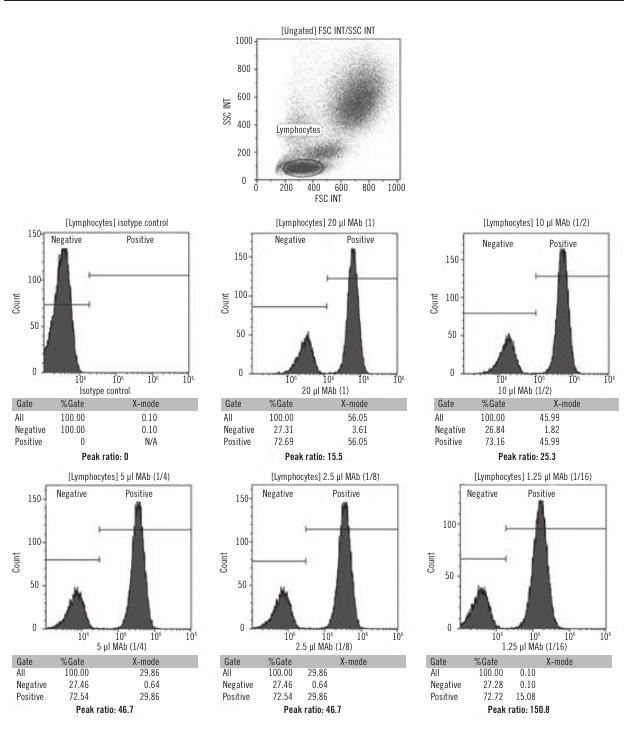
figuRE 2 − Example of MAb titration: 1 × 10 6 PB total cells labeled with IgG1 (mouse) – PE and different volumes/concentrations of CD3-PE, from the volume recommended by the manufacturer The analysis of lymphocytes region (SSC × FSC) shows that the optimal volume ranges from 5.0 μl (1/4) to 1.25 (1/16), because in these concentrations there were enough fluorescence intensity to identify the CD3 positive lymphocyte population from the other CD3 negative lymphocytes, which remained restricted to the region of unstained cells. The Peak Ratio values, 46.7 and 150.8 respectively, support the use of these volumes. MAb: monoclonal antibodies; IgG1: immunoglobulin G1 class; PE: phycoerythrin; SSC INT: side scatter integral; FSC INT: forward scatter integral; PB: peripheral